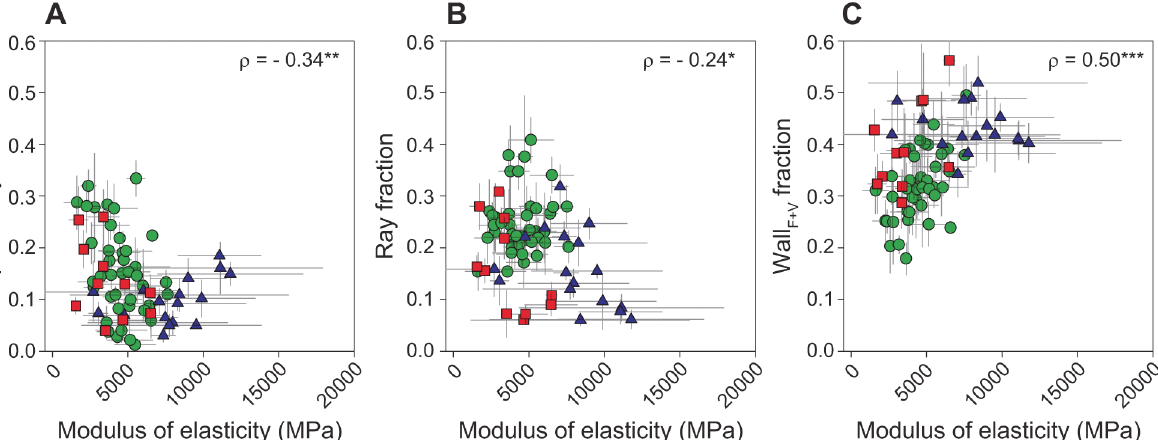
Fig 8. Relationships between axial and ray parenchyma fractions, wall F+V fraction and modulus of elasticity. Each symbol is an individual species. Symbol type represents site of collection: green circles — tropical rainforest (warm and wet site), red squares — tropical woodland (warm and dry site) and blue triangles — temperate forest (cool and wet site). * P < 0.05, ** P < 0.01, *** P < 0.001, **** P < 0.0001.